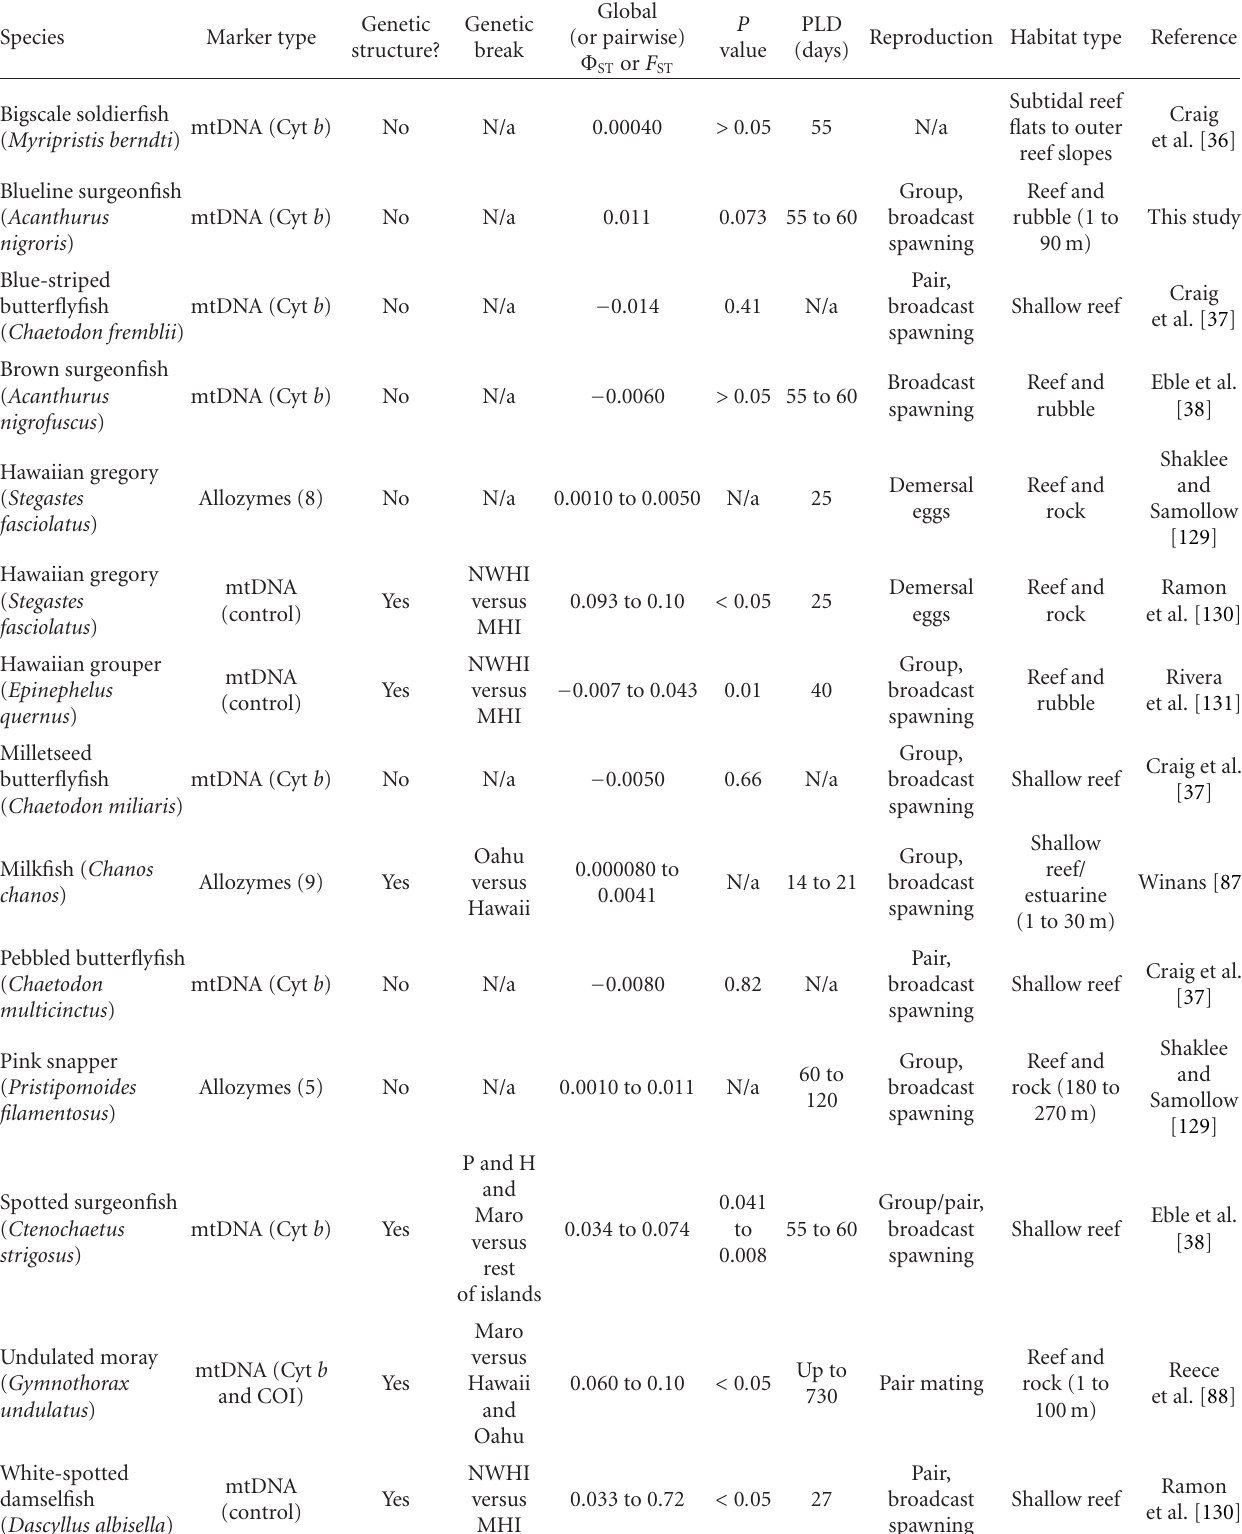
Table 5: Surveys of intraspecific genetic structure ( Φ ST or F ST ) in reef fishes sampled within the entire Hawaiian archipelago (i.e., Main Hawaiian Islands and Northwest Hawaiian Islands). Species common (and scientific) name, marker type (and mtDNA gene or number of nuclear loci), genetic structure, ecological di ff erences (pelagic larval duration, PLD; Habitat type) between the study species, and references are listed